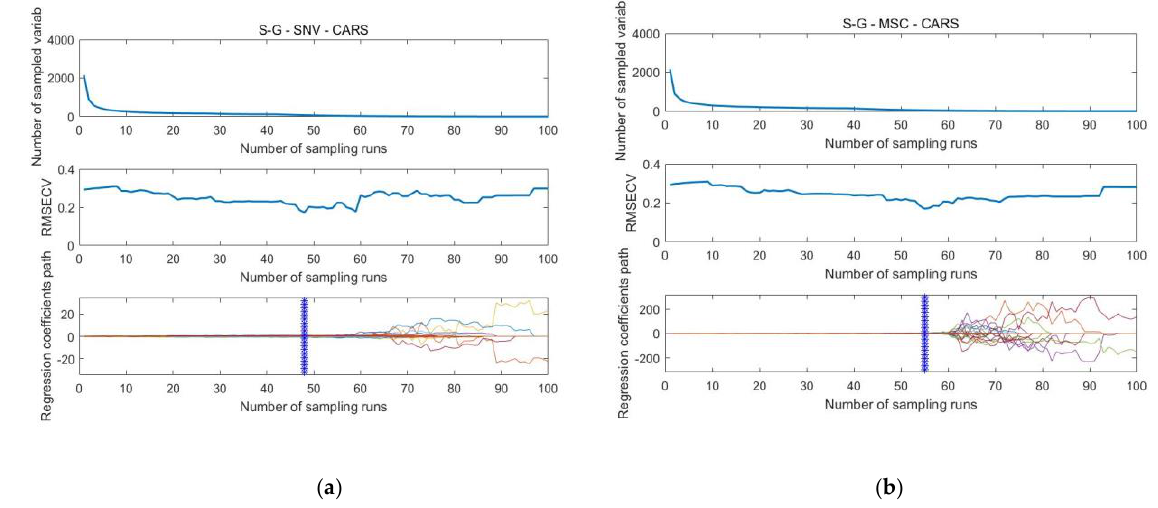
Figure 4. Variable selection results of SOM content VIS-NIRS based on CARS. ( a ) Effect of CARS on S-G-SNV pretreatment spectra and ( b ) effect of CARS on S-G-MSC pretreatment